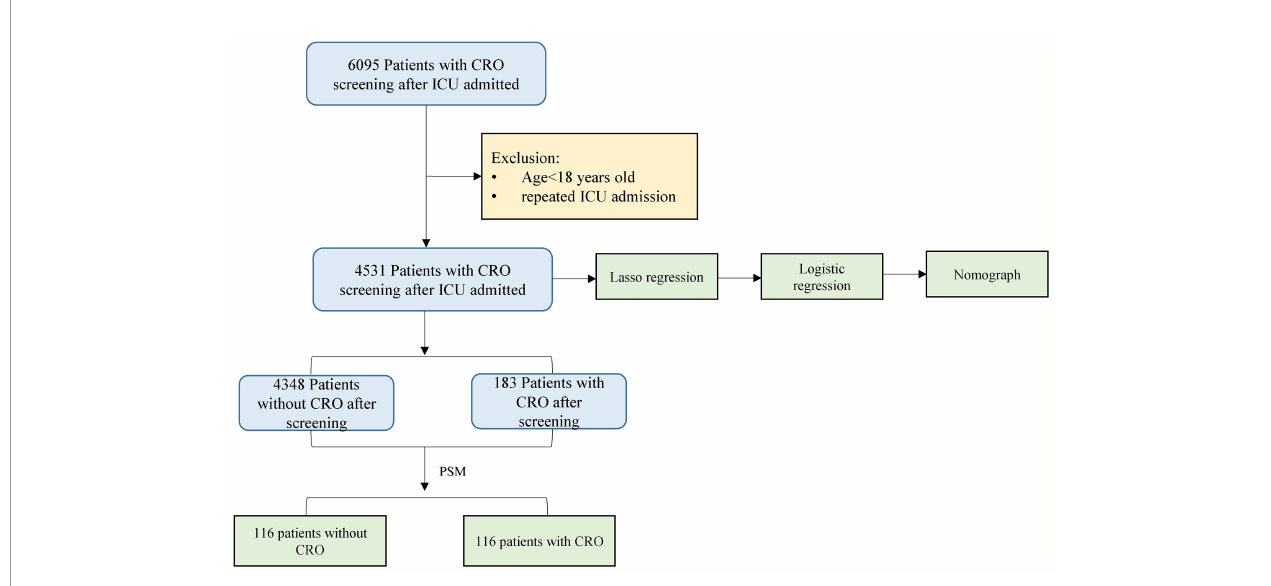
FIGURE 1 | Flowchart of study